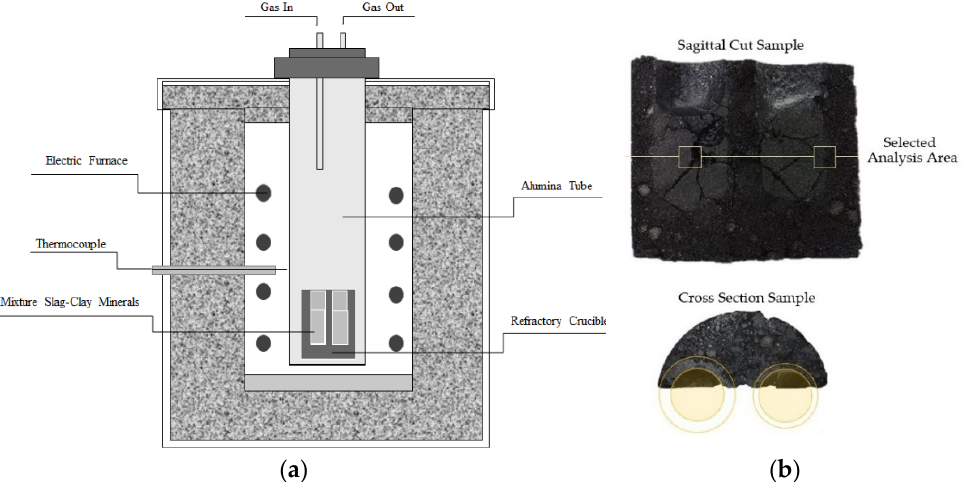
Figure 2. ( a ) Schematic arrangement for the corrosion static experiment; ( b ) magnesia chromite drill core cut and polished for characterization and analysis in the selected analysis area for the refractory hot face and the slag bulk.